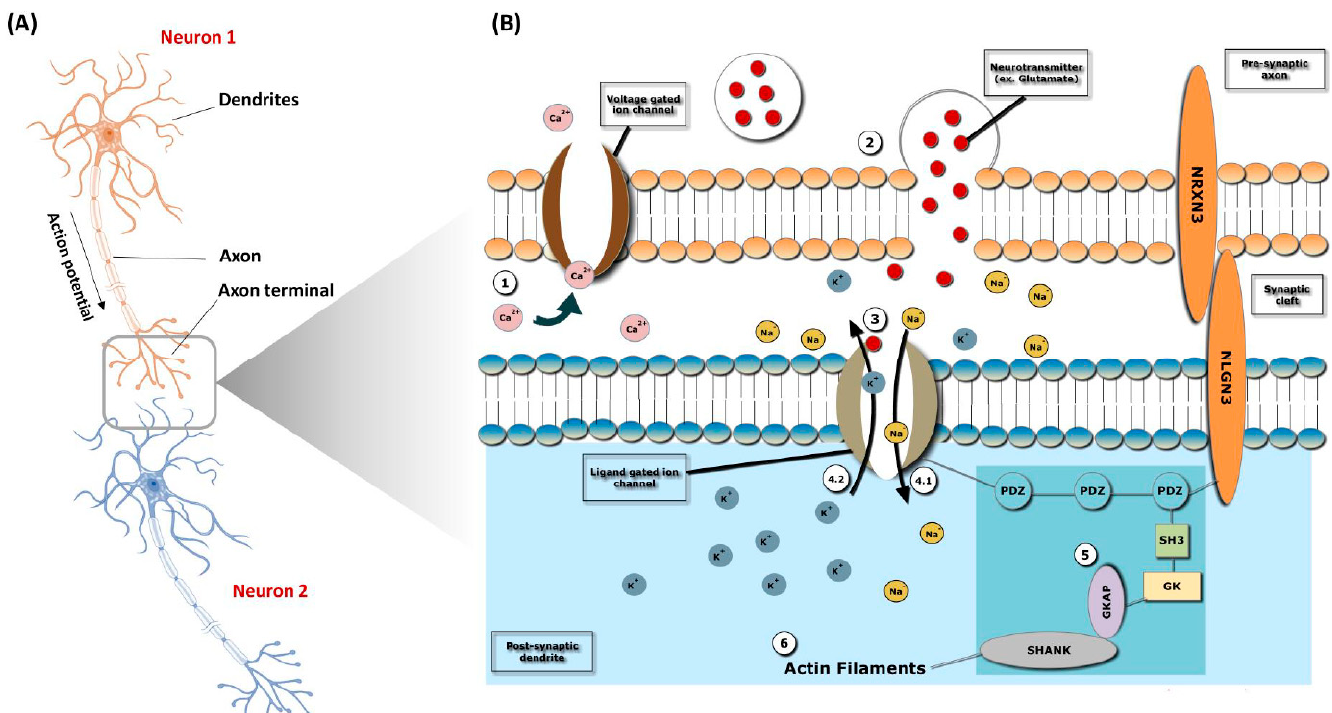
Figure 2. Synaptic transmission pathway (STP) of ASD. ( A ) Initiation of STP in a neuron upon receiving signals from another neuron. ( B ) Action potential and conversion of signals into chemical message: (1) Binding of cell adhesion molecules, NRXN1 (presynaptic axon) and NLGN3 (postsynaptic dendrite). Calcium (Ca 2+ ) enters into the cell. (2) Formation and release of vesicles containing neurotransmitters into the synaptic cleft. (3) Opening of the ligand gated ion channels and entry of sodium (Na 2+ ) into the cell. (4) Leaving potassium (K + ) out of the cell. (4) Activation of SHANK protein. (6) Molecular organization of postsynaptic density and modulation of postsynaptic signal transduction.